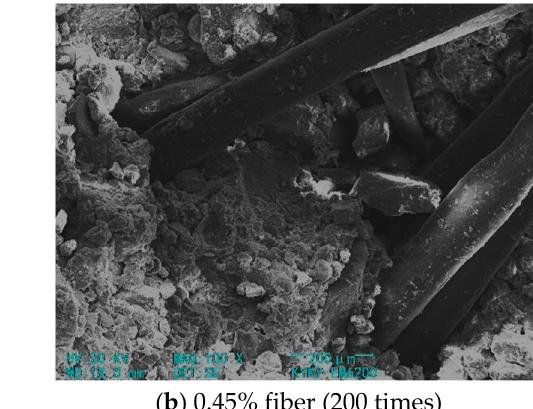
Figure 9. SEM picture of fiber FA cement–soil.